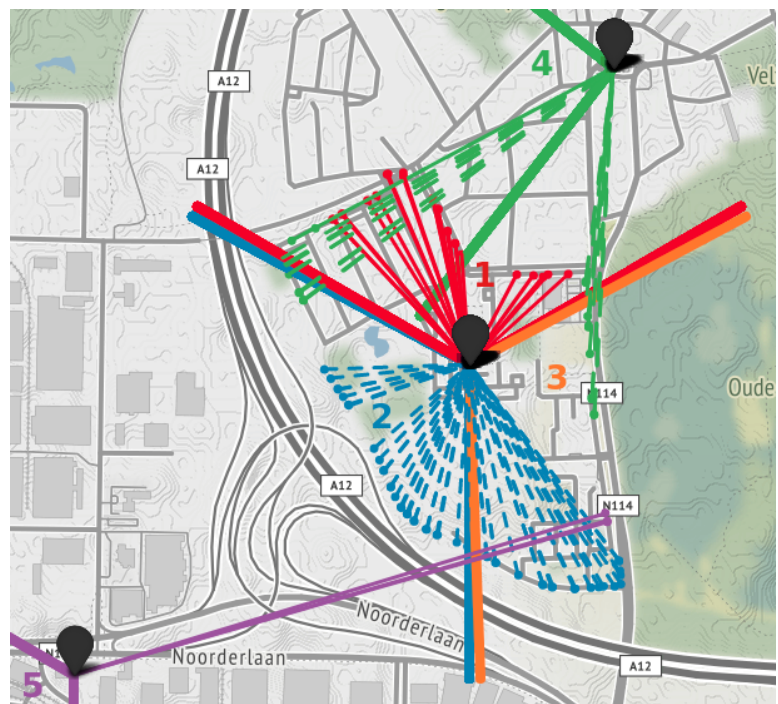
Figure 7. Visualization of NB-IoT cell reselection when moving at a constant speed around an eNB with three cell sectors. The color and pattern of the line connecting the GPS location of the UE to the eNB indicates the currently serving cell. The cell sector boundaries are indicated with thicker